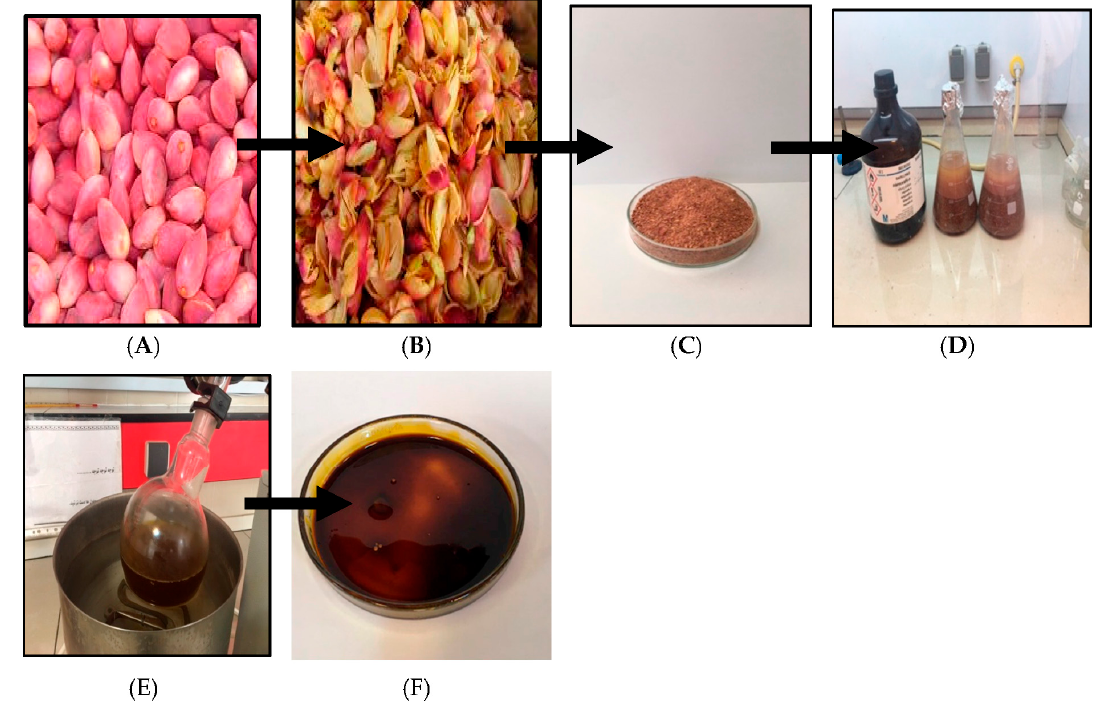
Figure 11. Extraction method of PVLH ( A ) fresh; ( B ) drying; ( C ) powder; ( D ) maceration; ( E ) evaporation and ( F ) extract